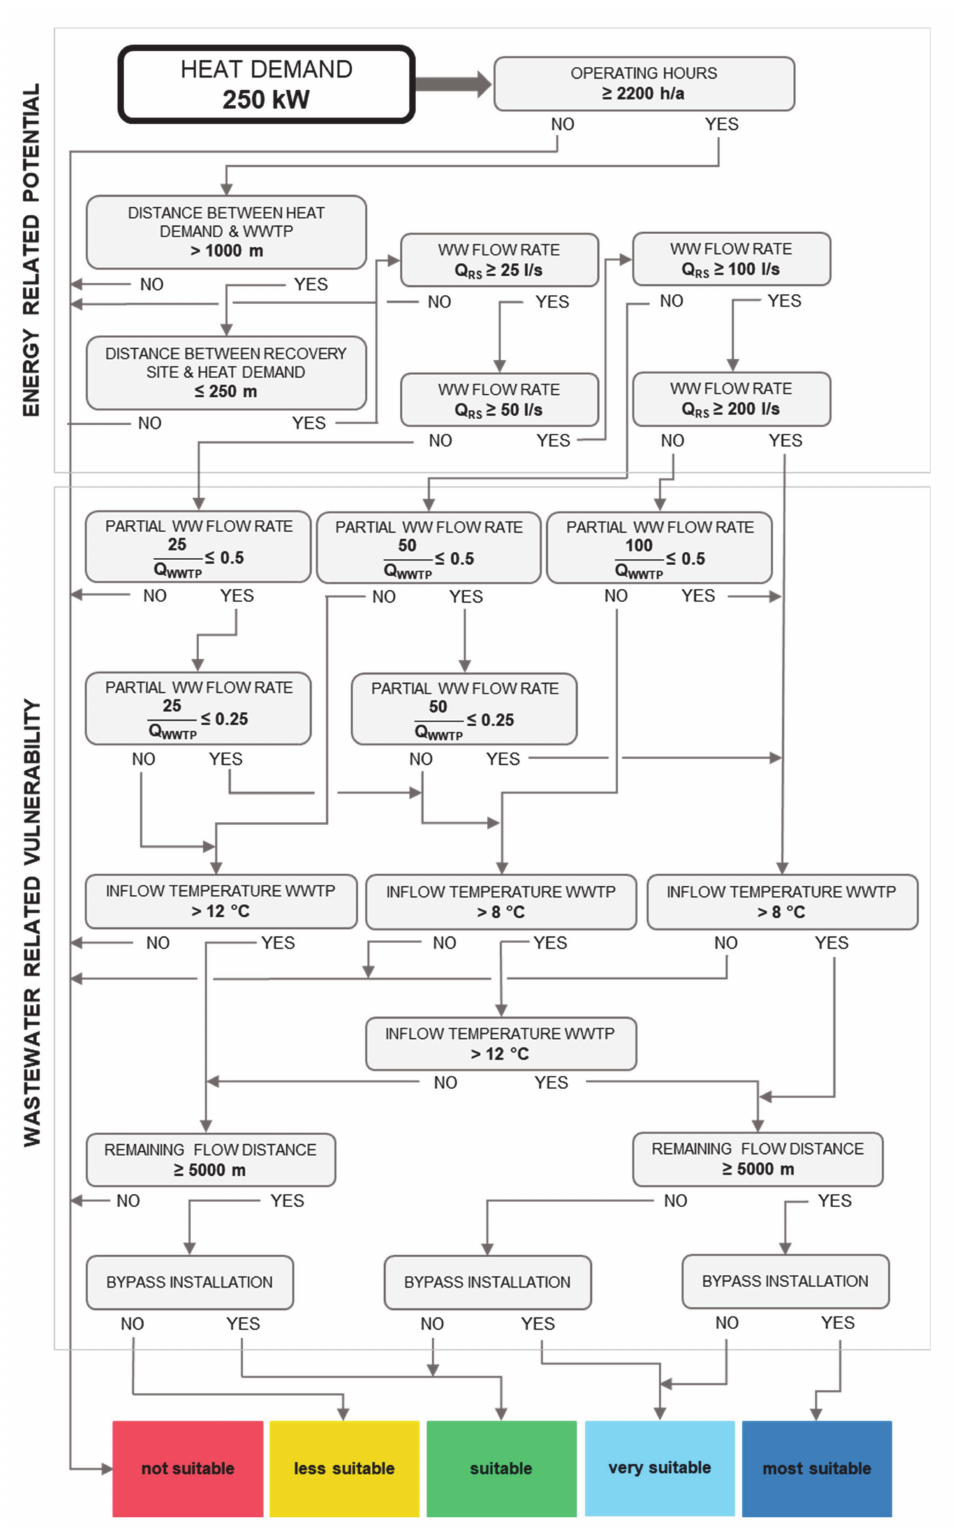
Figure A7. Relevance tree for an intended heat supply of 250 kW (own representation, based on